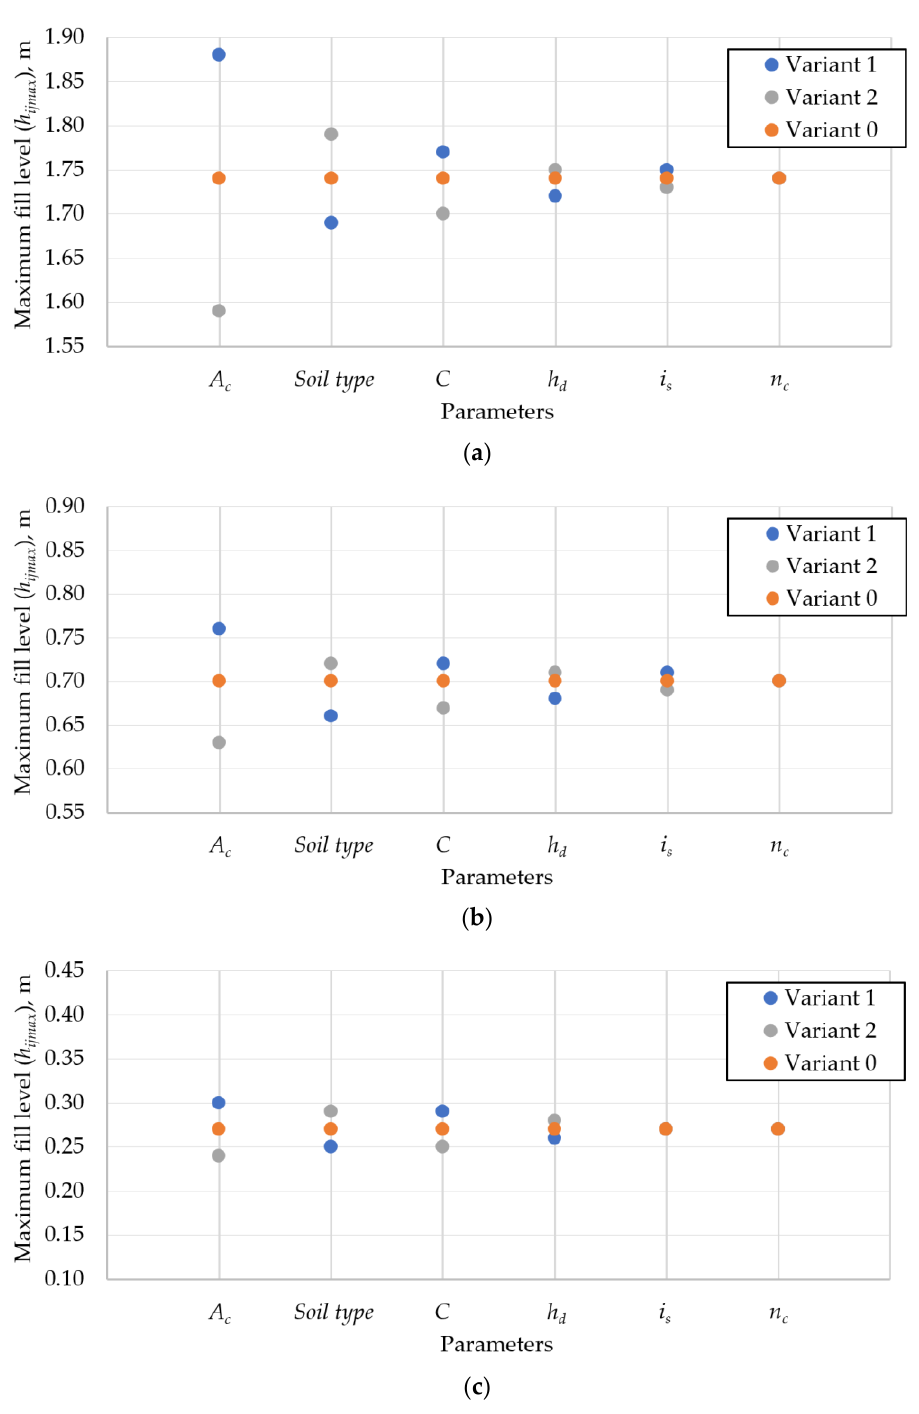
Figure 16. Maximum level of fill in the stormwater infiltration facility: ( a ) 19 June, 2020 — p = 0.00098; ( b ) 19 May, 2019 — p = 0.065; ( c ) 8 August, 2019 — p = 0.53 (designations as in Figure 2).